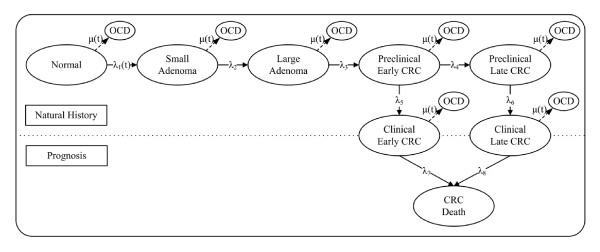
Markov process for disease natural history and prognosis of colorectal cancer (CRC).* * The ovals represent Markov states; the solid arrows represent the direct transition between states, and the dotted arrows represent the transition toward competing cause of death. Abbreviations: Small adenoma, adenoma smaller than 1 cm in size; large adenoma, adenoma larger than 1 cm in size; early CRC, Dukes' stage A and B colorectal cancer, late CRC, Dukes' stage C and D colorectal cancer; OCD, other cause of death.